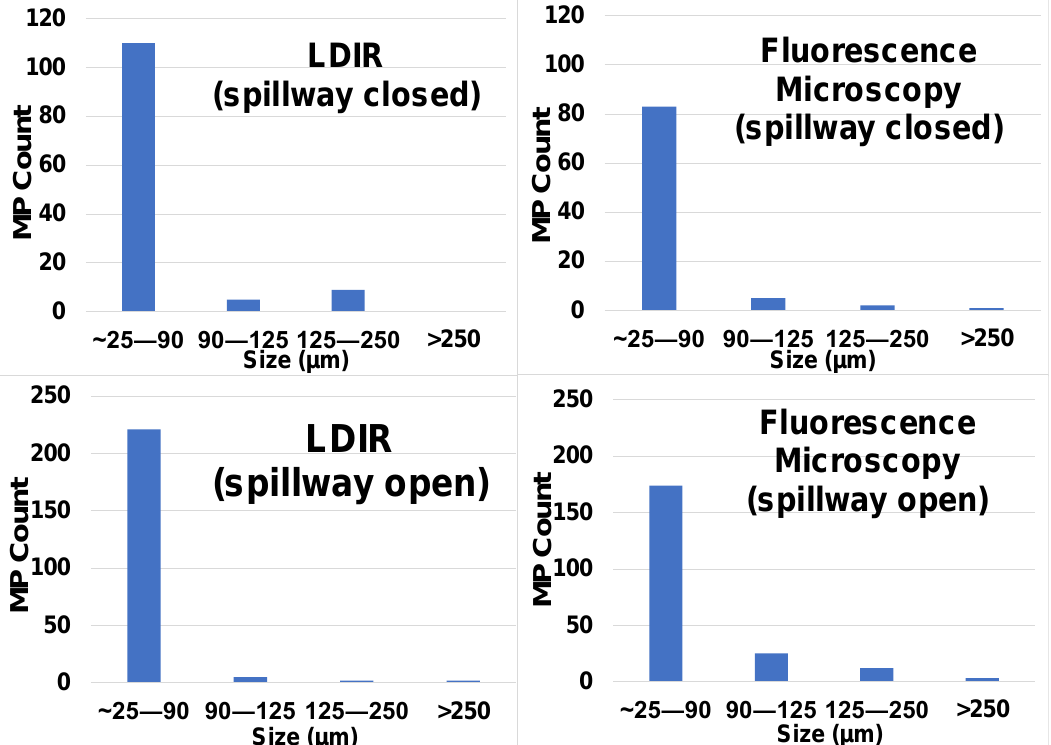
Figure 4. Particle size distribution of microplastics from 1 L of seawater collected in the Mississippi Sound and determined by Laser Direct Infrared (LDIR, left) and fluorescence microscopy (right). Note the different scale for MP counts for spillway open (top, indicating freshwater intrusion) and spillway closed (bottom, representing normal salinity conditions).